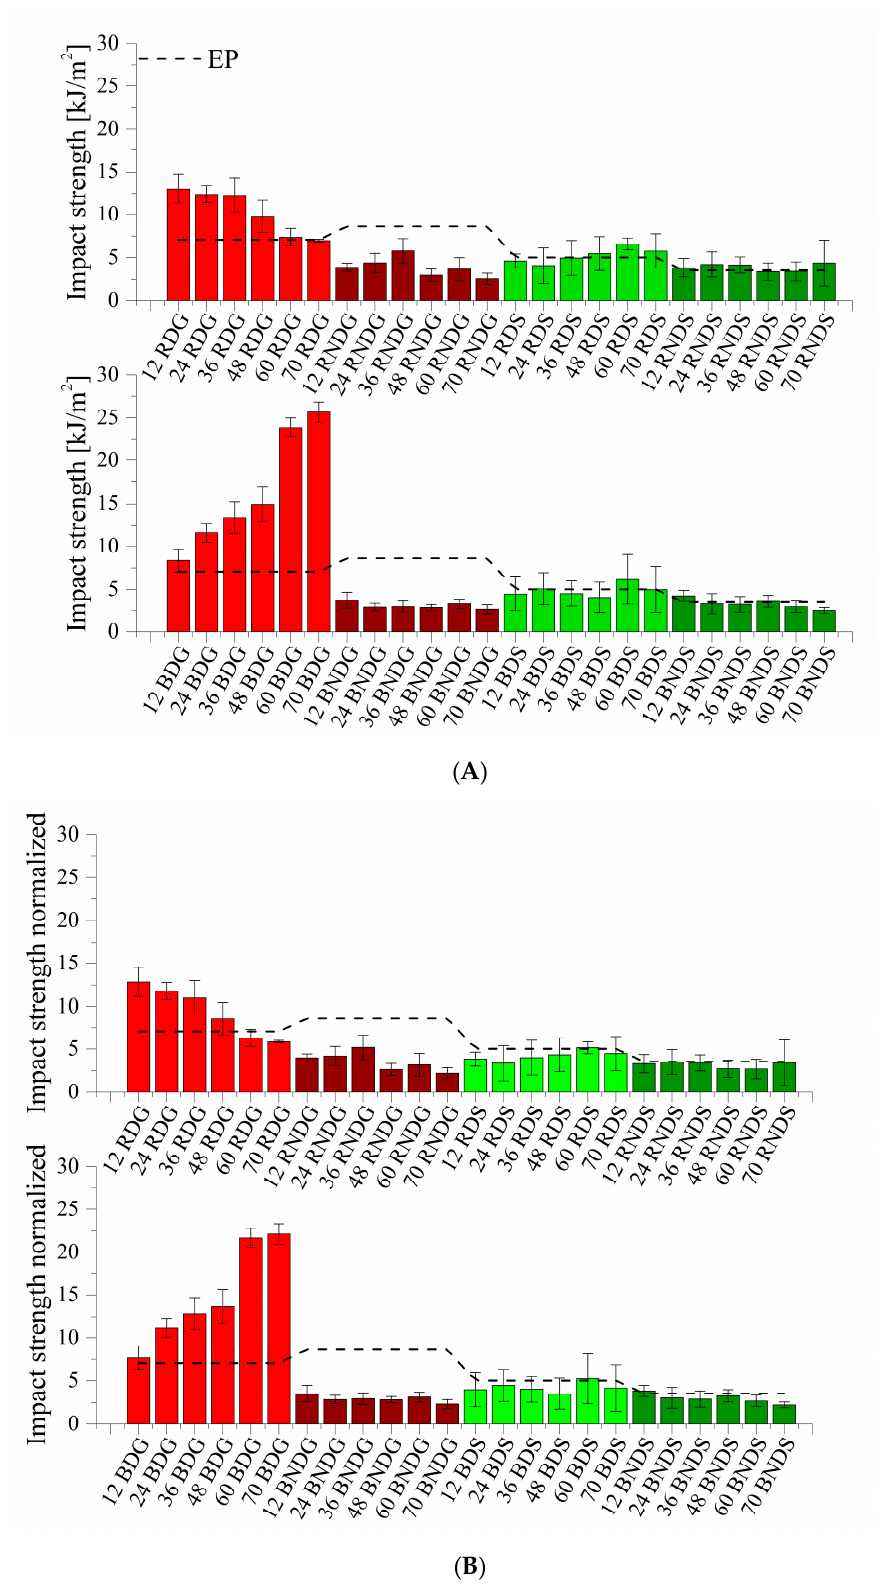
Figure 14. ( A ) Impact strength for systems containing base and fractionated diatoms. ( B ) Impact strength for systems containing base and fractionated diatoms, density normalized.